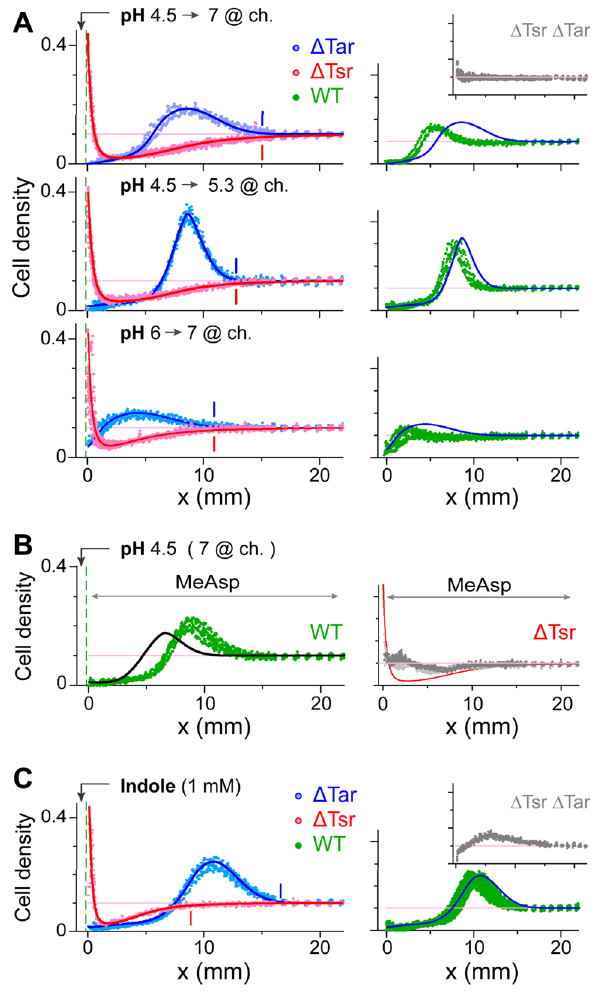
Figure 4. The behavior of mutant cells lacking either Tar or Tsr. ( A ) The distribution of ΔTar (blue symbols), ΔTsr (red symbols), or wild type (green symbols, right plots) cells along the channel 3 h after the introduction of a low-pH source. Data are shown for different pH values at the source and in the channel, as labeled. To allow direct comparison, the fit to the ΔTar data is also shown in the right plots (blue lines). Inset —the distribution of cells lacking both receptors. ( B ) Left plot —the distribution of wild-type cells 3 h after the introduction of a low-pH source in the presence of uniformly distributed MeAsp (10 mM; green symbols). To allow direct comparison, the fit to the corresponding bacterial distribution in the absence of the MeAsp background is also shown (black line). Right plot —the distribution of ΔTsr cells in similar experiments at 1 h and 3 h (light and dark grey, respectively). ( C ) As in (A, upper part) but with indole (1 mM) added to the source instead of low pH. Throughout, cell density is normalized to the cell density at OD 600 1, and the initial uniform bacterial density (0.1) is marked by the light pink